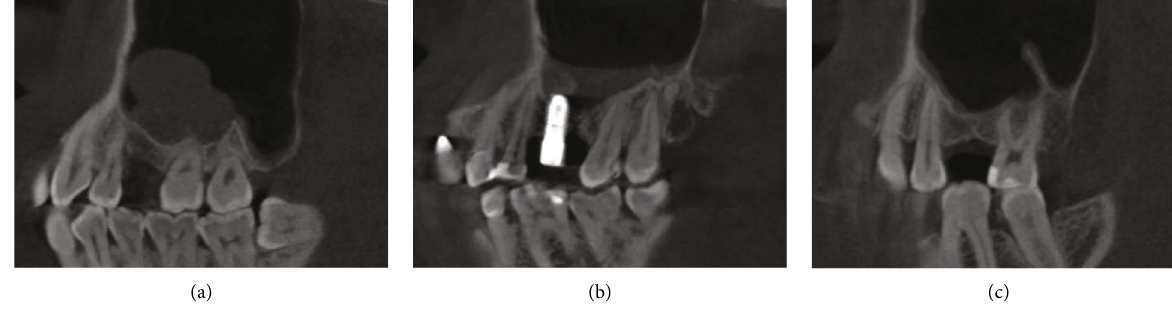
Figure 10: Possible reasons for unsatisfactory morphologies. (a) cyst; (b) sinus membrane perforation; (c) oblique sinus floor.